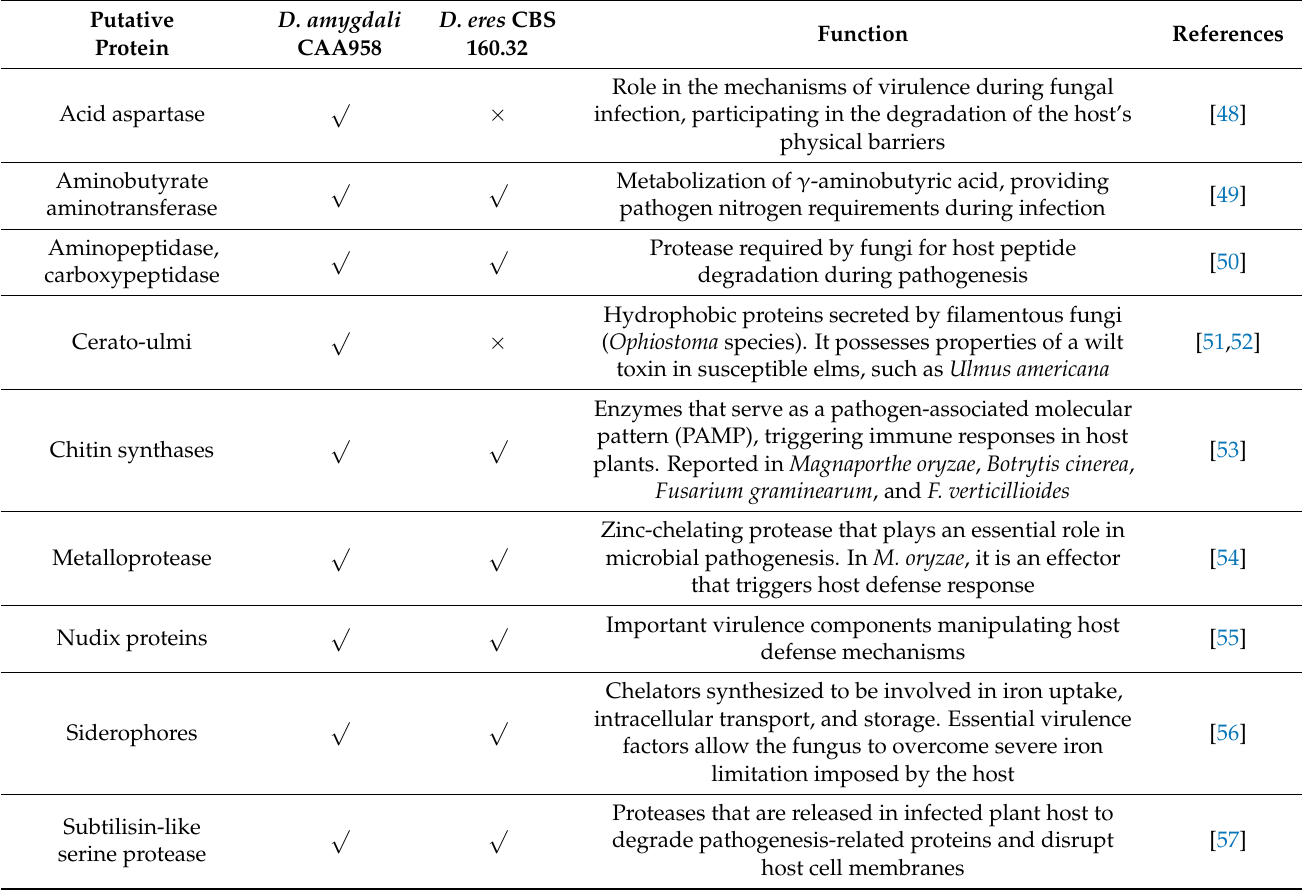
Table 3. Putative proteins involved in fungal pathogenesis identified in the genomes of Diaporthe amygdali CAA958 and Diaporthe eres CBS